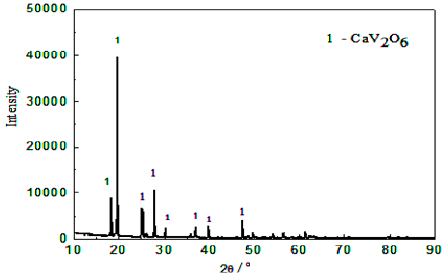
Figure 1. XRD patterns of the synthetic sample.